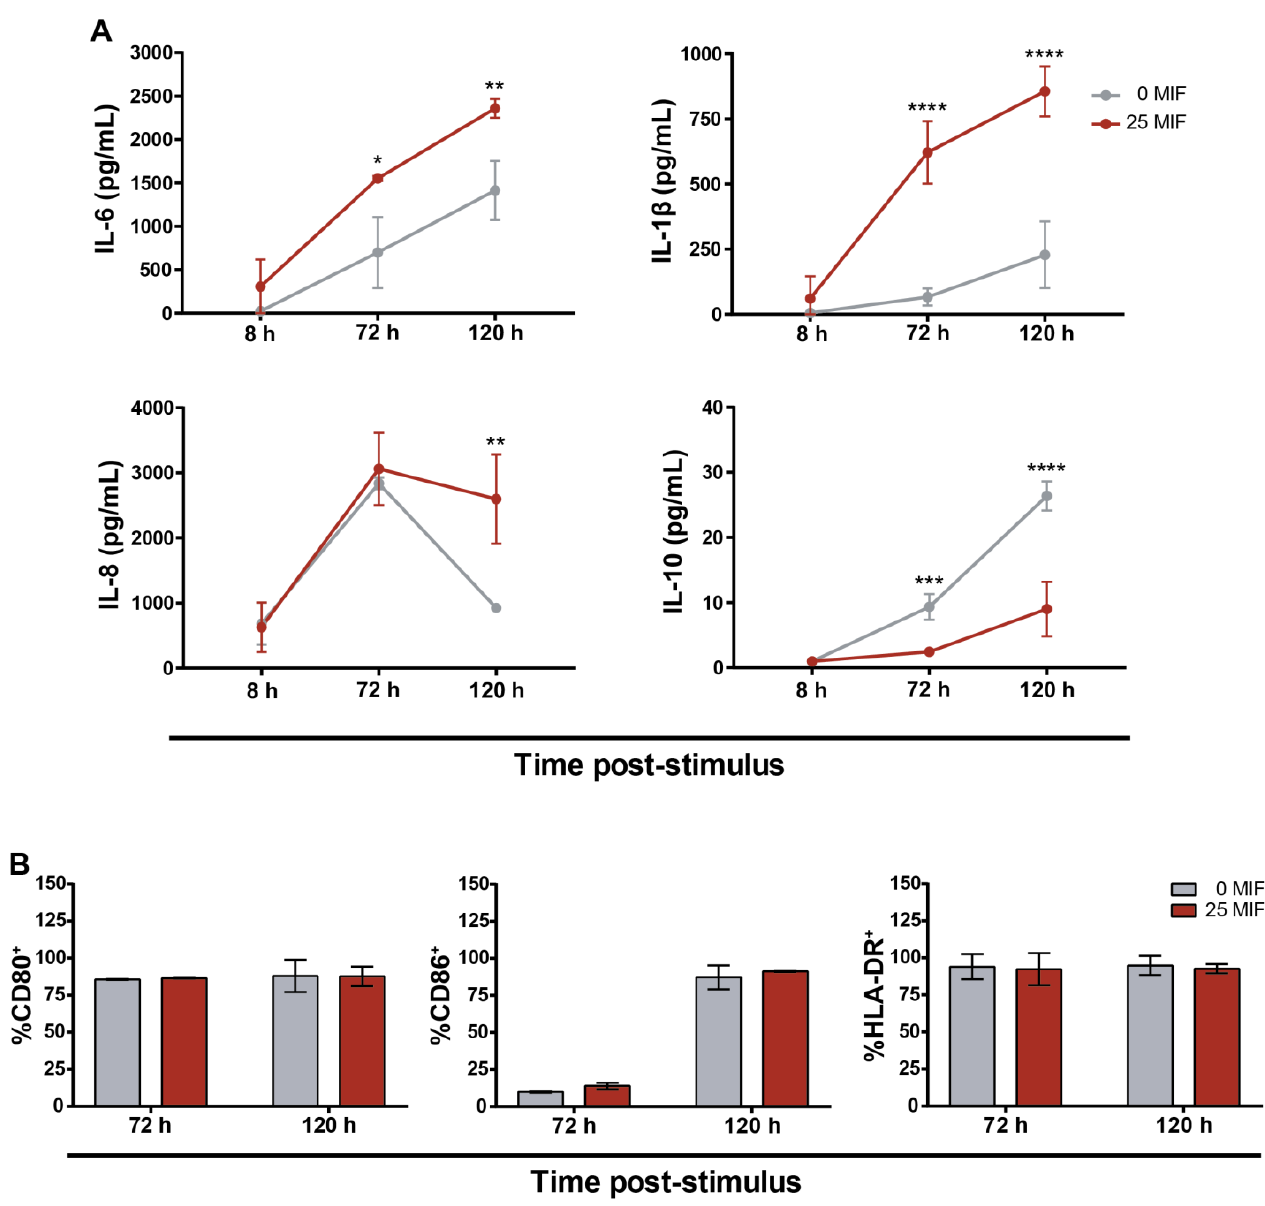
Figure 1. Activation status of HIV-infected MDMs after MIF stimulus. ( A ) Concentration of IL-6, IL-1 β IL-10 and IL-8 in supernatants from HIV-infected MDMs treated (dark red lines) or not (grey lines) with MIF. ( B ) CD80, CD86 and HLA-DR surface expression on HIV-infected MDMs treated (dark red bars) or not (grey bars) with MIF after 72 and 120 h of stimulus. Data show the mean ± SD of three independent experiments each one performed in triplicate. Data analysis was performed by one-way ANOVA and Sidak’s post-test. * p < 0.05, ** p < 0.01, *** p < 0.001, **** p <